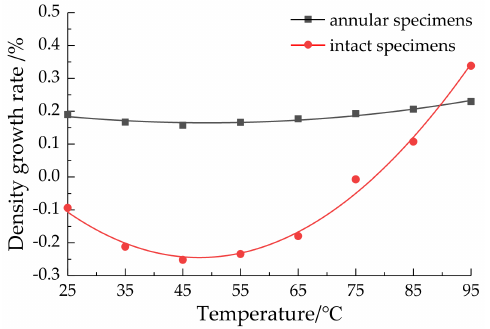
Figure 7. Density growth rate varies with water